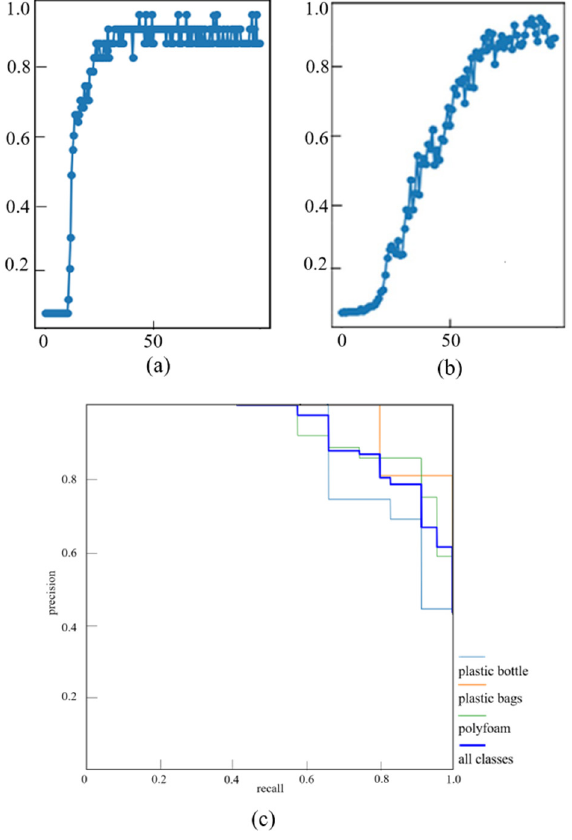
Figure 9. The modified YOLOv5 accuracy evaluation. ( a ) Precision curve; ( b ) recall curve; ( c ) AP, mAP curve.